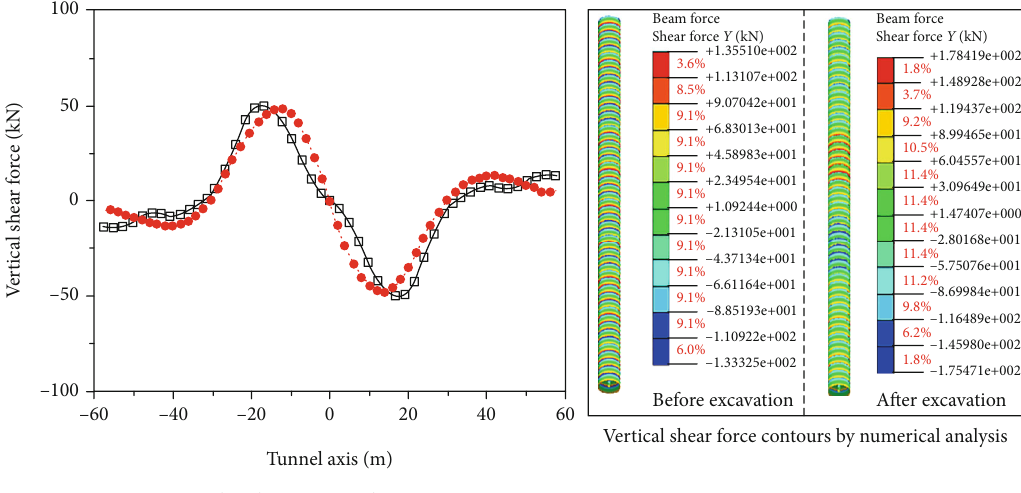
Figure 11: Excavation-induced tunnel vertical shear forces by numerical and theoretical calculation.